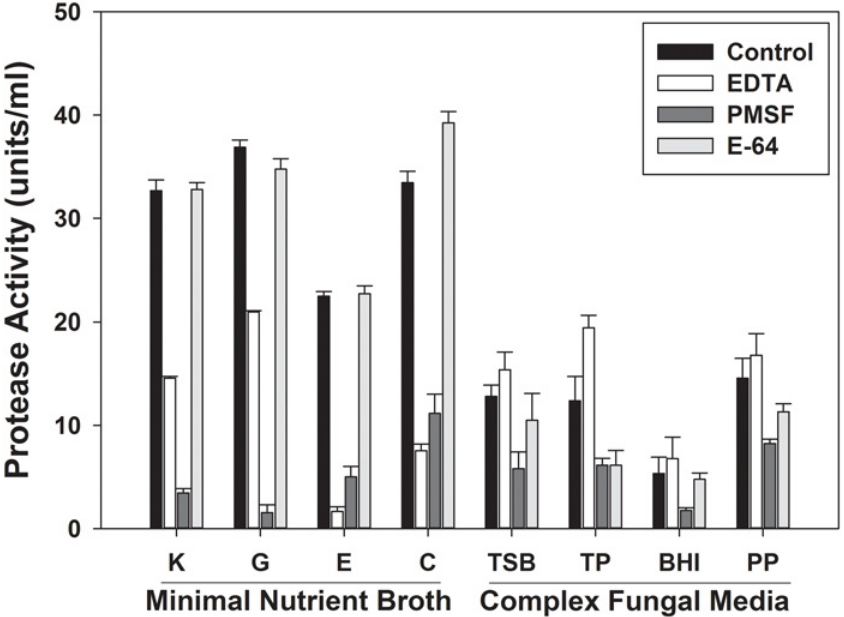
Fig 2. Total protease activity (units x 10 3 /ml) secreted by P . destructans grown in static liquid cultures. Various protein-supplemented minimal nutrient broth media and complex culture media were used. Controls are total activity accumulated in culture medium, and residual activity was determined following treatment with the protease inhibitors EDTA, PMSF, and E-64. Minimal nutrient broth with K, keratin, G, gelatin, E, elastin, C, casein. Complex media: TSB, tryptic soy broth, TP, tryptone peptone, BHI, brain-heart infusion, PP, proteose peptone. (Mean and standard error for triplicate